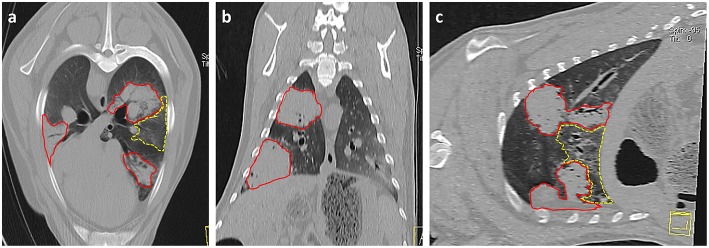
Thoracic CT images of OPA tumors. (a) Axial, (b) Coronal, and (c) Sagittal planes. Three large areas of increased radiopacity are seen within the lung lobes consistent with advanced OPA tumors (outlined in red). One lesion is present within the dorsal region of the left cranial lung lobe with a further lesion in the ventral region of the left caudal lung lobe. A smaller lesion is present within the right caudal lung lobe. A patchy and hazy area of increased opacity (ground glass appearance), with preservation of bronchial and vascular patterns, is present (outlined in yellow) between the two tumors in the left lung lobes. This area is consistent with regions of neoplastic foci or a secondary pneumonia.